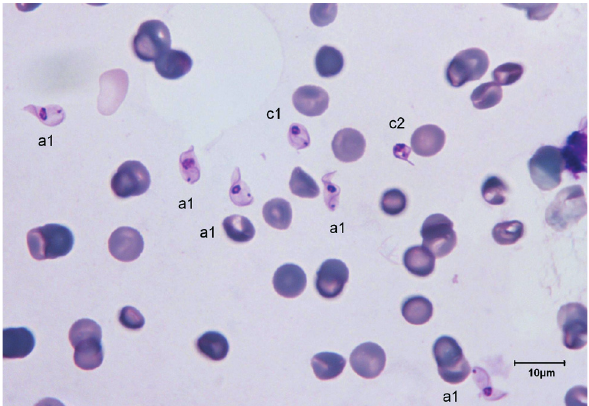
Fig. 3. – Typical T. (Nannomonas) hyperpachymorph (a) (five specimens) and the two types of sphaeroblasts ( T. (Nannomonas) sphaeromorph) (c). Photo by Bruno Polack. Montgomeryi -type sphaeroblast is light in colour and large (c1); congolense -type sphaeroblast is densely coloured and small, with a visible free flagellum (c2).